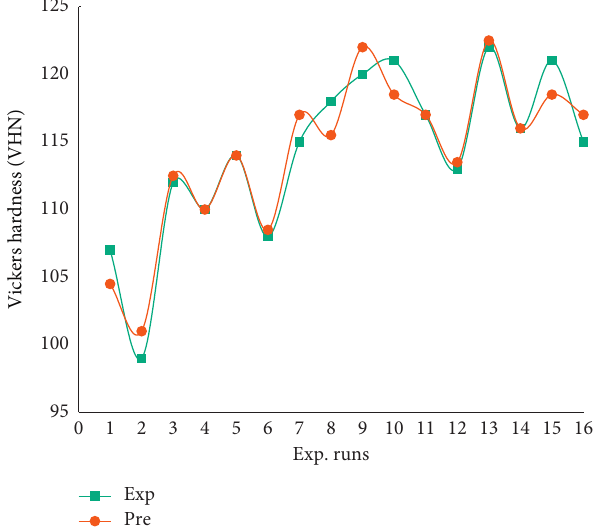
Figure 14: Experimental runs versus Vickers microhardness.